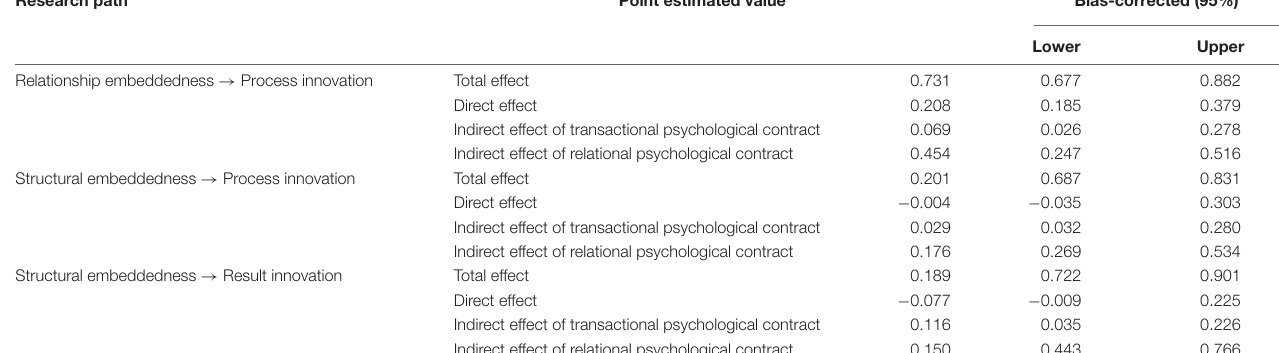
TABLE 7 | Mediation analysis with bootstrap. Research